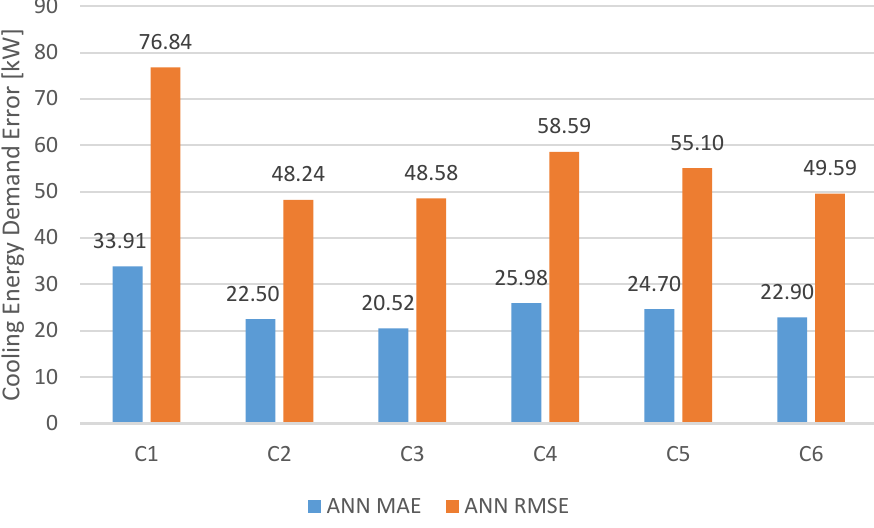
Figure 5. Error metrics for cooling energy demand using artificial neural networks (ANN).